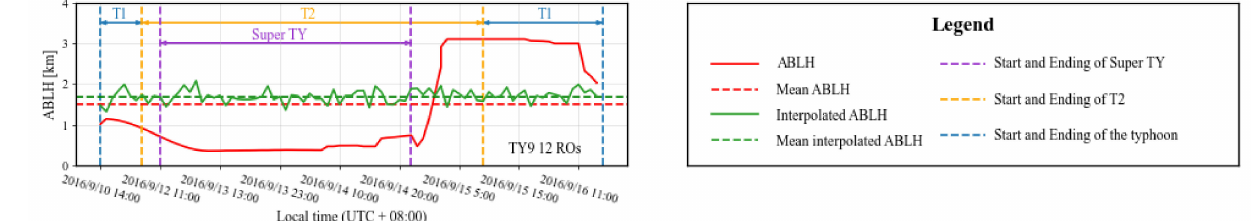
Figure 7. Variation in the ABLH along each typhoon’s (TY1–TY9) track, resulting from the co-located COSMIC profiles (based on a 600 km space window and a 36 h time window, red curve) and the results from ABLH climatology (green curve). The red and green horizontal dashed lines are the mean ABLH during the typhoon period obtained from the co-located RO profiles and the climatology. The stages of T1, T2, and super TY are represented by the blue, orange, and purple vertical dashed lines, respectively.